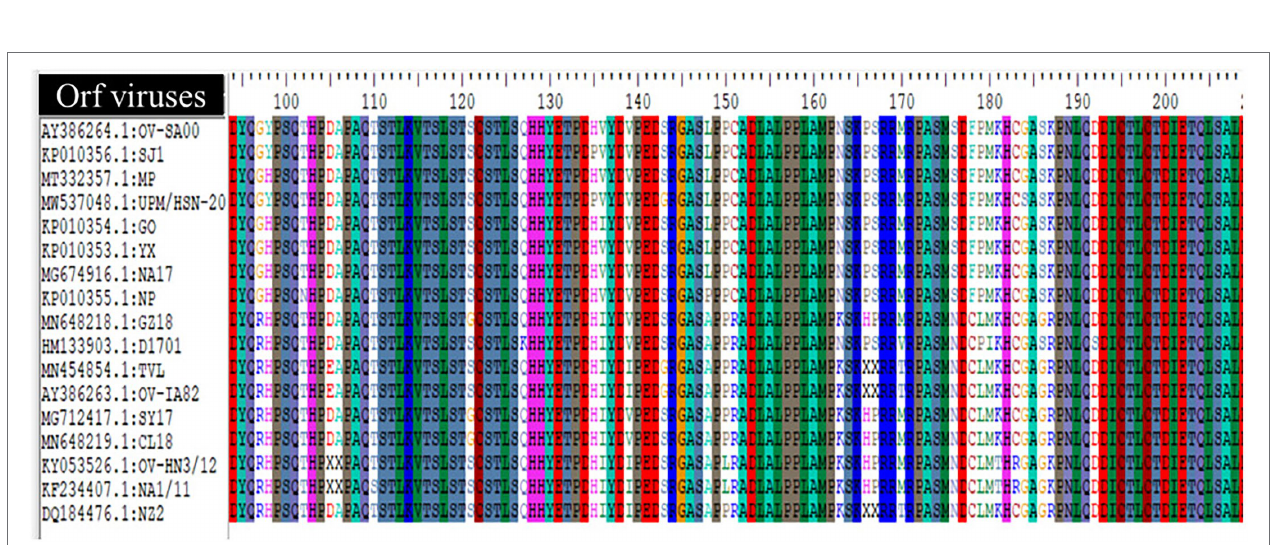
FIGURE 4 | Phylogenetic tree based on ORF008 of parapoxviruses. The tree was constructed using the maximum likelihood methods and Tamura-Nei model with 1000 bootstrap replicates in NIEGA-X software.